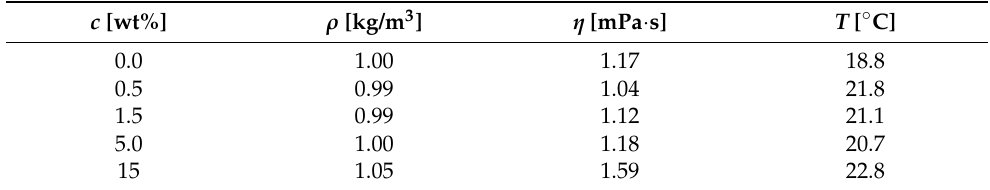
Table 1. Measured values of density ρ , viscosity η , and temperature T at each concentration c of the citric acid used in the